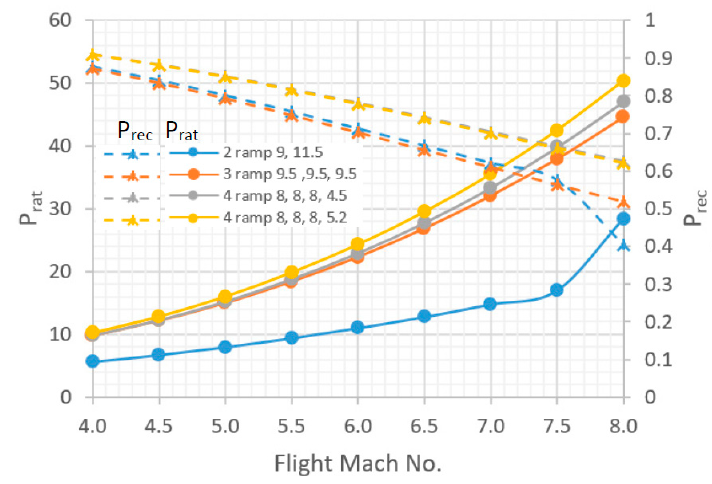
Figure 20. Theoretical compression and pressure recovery of the inlets.